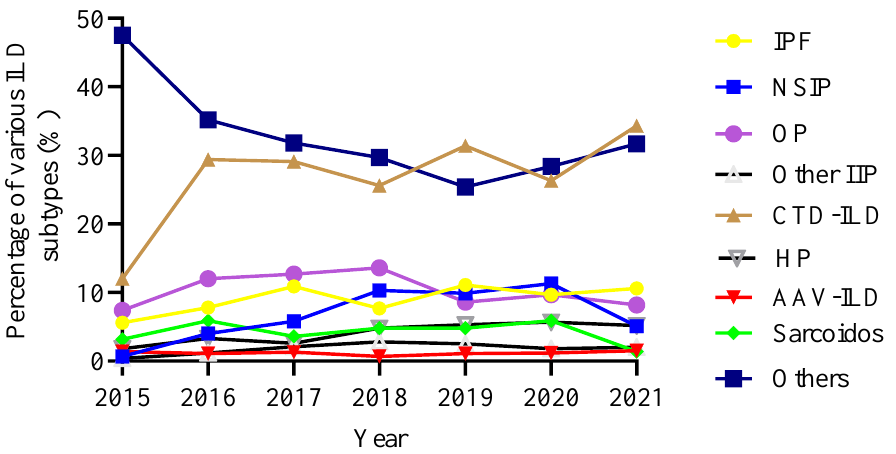
Figure 3. Trends in the proportion of ILD subtypes over time. ILD, interstitial lung disease; IPF, idiopathic pulmonary fibrosis; NSIP, nonspecific interstitial pneumonia; OP, organizing pneumonia; CTD-ILD, connective tissue disease-associated ILD; HP, hypersensitivity pneumonitis; AAV, anti-neutrophil cytoplasmic antibodies-associated vasculitis.